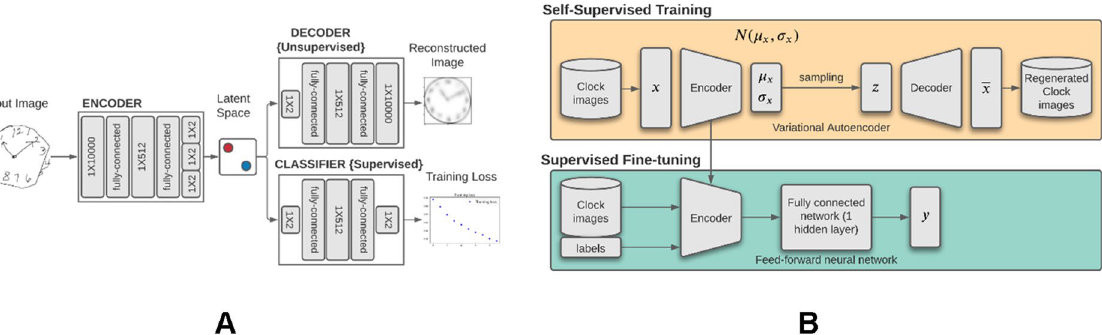
Figure 5. Conceptual workflow for training VAE with unlabeled dataset and constructing classifiers with latent space of VAE. ( A ) Clock images are passed into the VAE encoder in the form of a 1X10,000 vector. The top part of the schema represents the VAE decoder-encoder couplet which is trained to minimize the reconstruction loss of the clock drawing using an information bottleneck of a two-dimensional latent space. The lower part of the figure shows how the latent dimensions which capture a compressed representation of a clock drawing are passed into a classifier that mimics the architecture of the VAE decoder. This classifier is fine-tuned to reduce the loss in predicting dementia. ( B ) This image differentiates between the self-supervised pre-training of the VAE versus the usage of the pre-trained VAE encoder for downstream